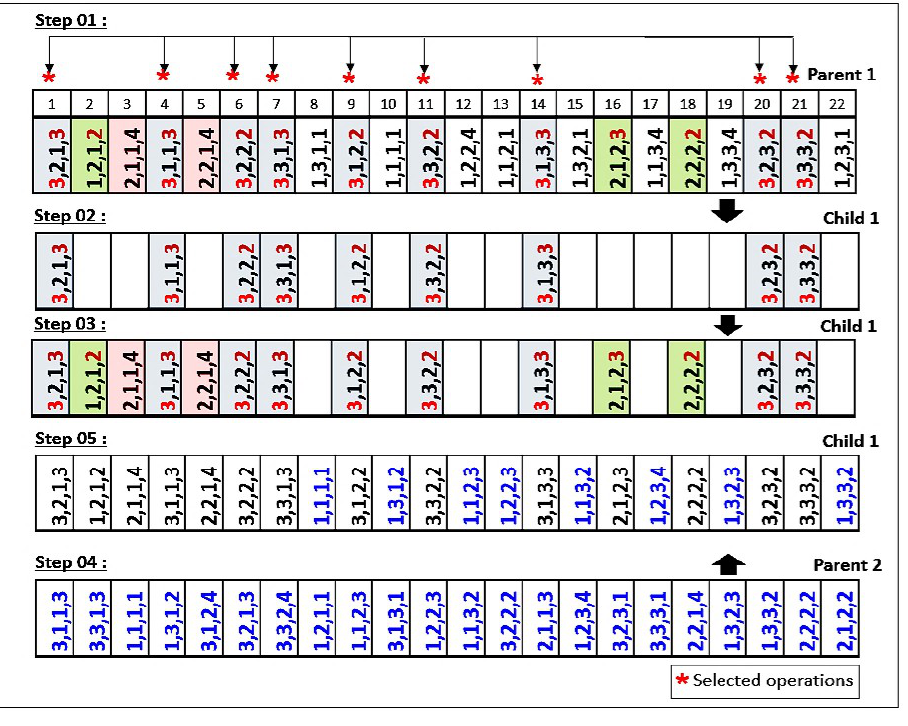
Figure 5. JLOSC2 (job-level operation sequence crossover 2) operator.